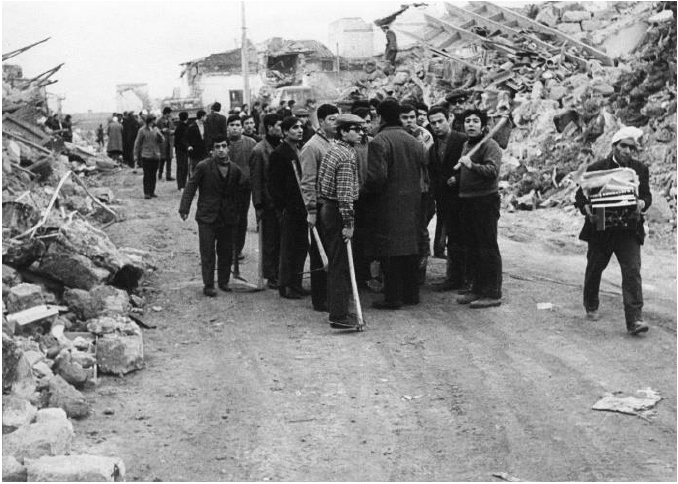
Figure 6. Intervention of the early volunteers. Photo: Archivio de L’Ora, Biblioteca Regionale Siciliana “Alberto Bombace”, Palermo.